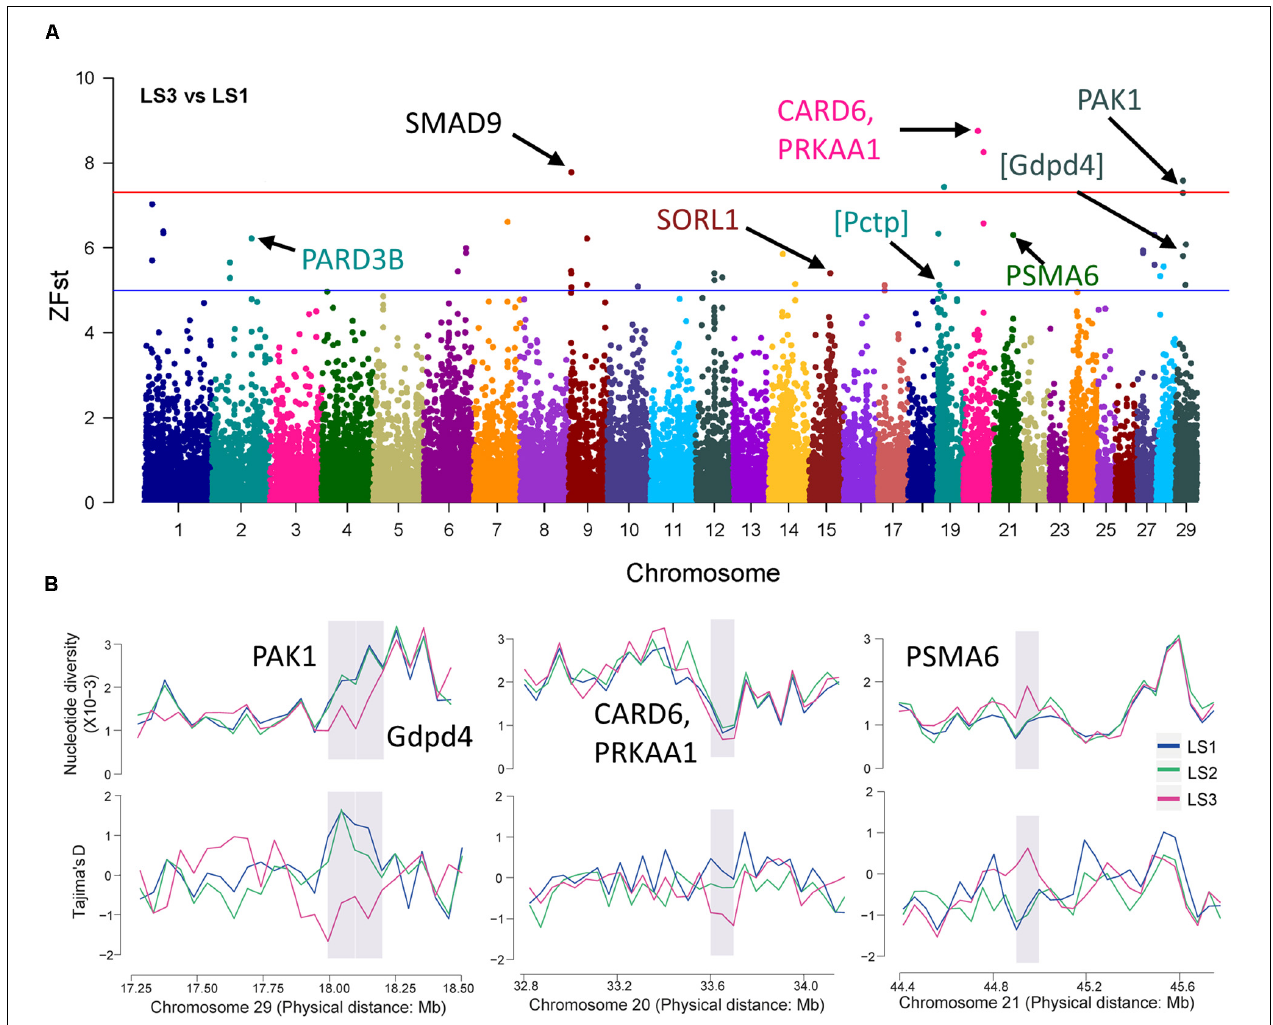
FIGURE 4 | Selective sweep of Jining Gray goat groups with LS3 vs LS1. (A) Mahattan Plot of Z(Fst) values of LS3 vs LS1 groups. The blue line is “suggestiveline,” –log10(1e – 05), red line is “genomewideline,” –log10(5e – 08). (B) Distribution of Tajima’s D values and π in LS1, LS2, and LS3 groups at selective regions. The selective regions were marked with gray